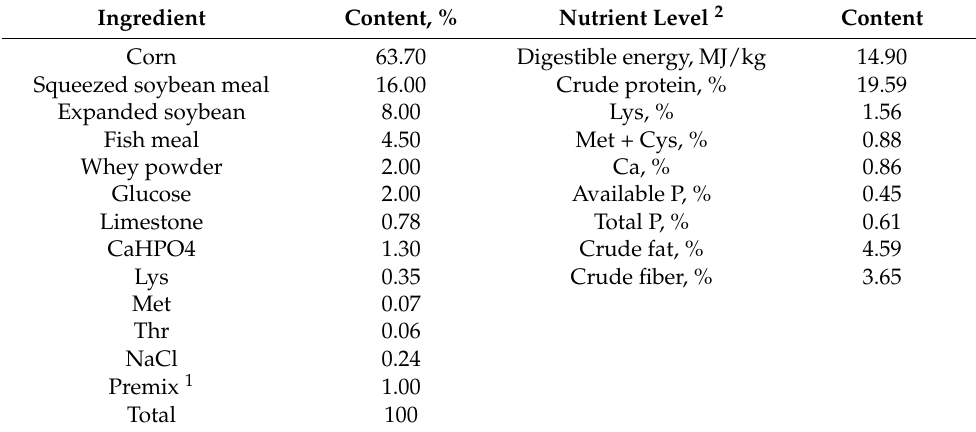
Table 1. Composition of the basal diet and nutrition level (dry